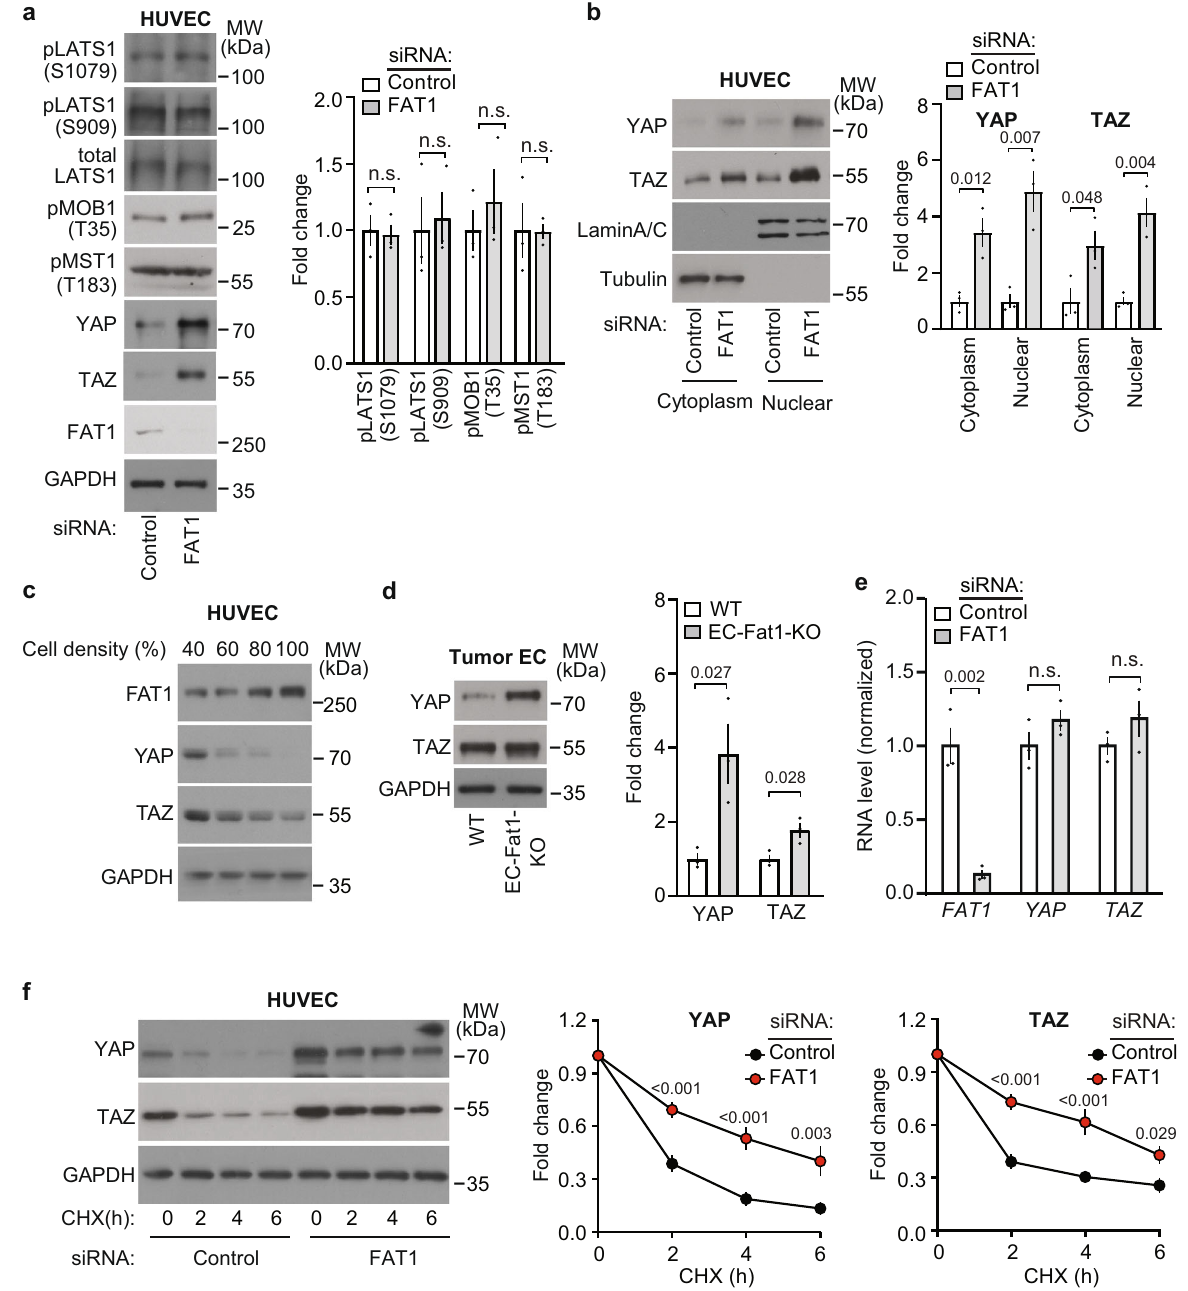
Fig.5|LossofFAT1expressionresultsinincreasedYAP/TAZproteinstabilityin HUVECs. a Immunoblot analysis of total and phosphorylated Hippo pathway componentsinlysatesofHUVECstransfectedwithcontrolsiRNAorsiRNAdirected against FAT1 . Shown is a representative blot and the densitometric analysis ( n